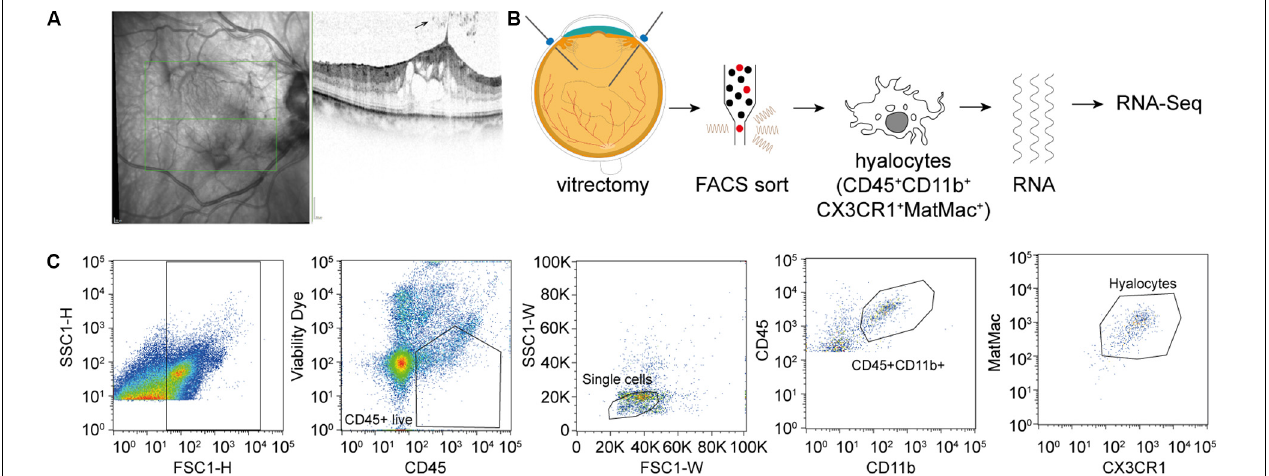
FIGURE 1 | Experimental Setup. (A) Study subjects were diagnosed by funduscopic examination and optical coherence tomography (SD-OCT). The arrow points at a cell in the vitreous cavity of a patient with macular pucker, most likely one of a group of hyalocytes. (B) After performing a standard vitrectomy the content of a single vitrectomy collection bag was treated according to a FACS protocol developed for the project, hyalocytes were sorted and then subjected to RNA sequencing analysis. (C) Flow cytometric gating strategy for human hyalocytes characterized as CD45 + CD11b + CX3CR1 + MatMac + cells. Cell populations were defined by fluorescence intensity after exclusion of dead cells and doublets by viability dye and physical parameters (FSc, SSc): FSc, forward scatter; SSc, sideward scatter; H, Height; and W,